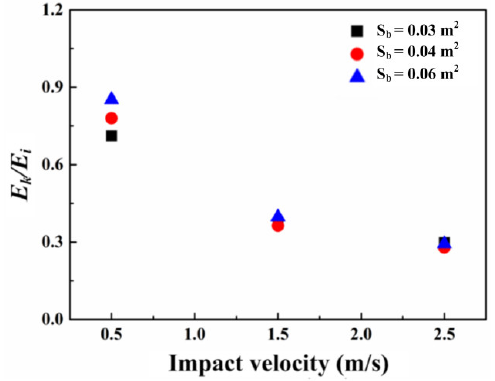
Figure 16. The influence of impact velocity on absorbed energy during the failure process.